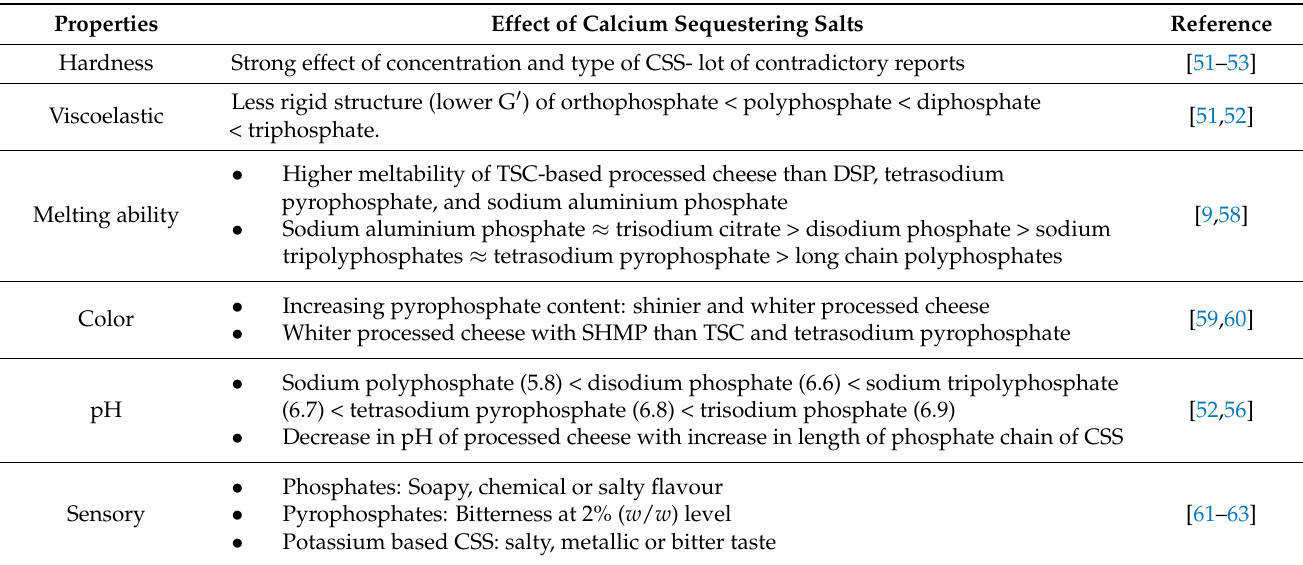
Table 3. Effect of different calcium sequestering salts on physico-chemical, functional and sensorial properties of processed